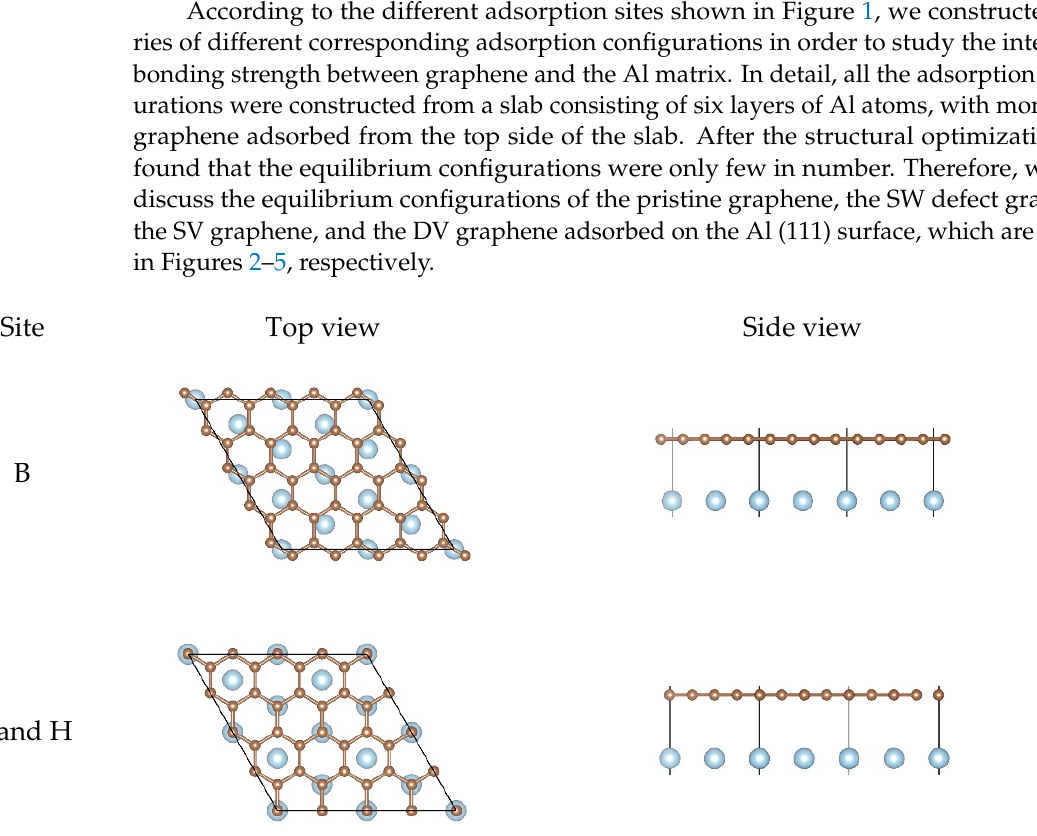
Figure 2. Top views and side views of the pristine graphene on the Al (111) surface after the structural